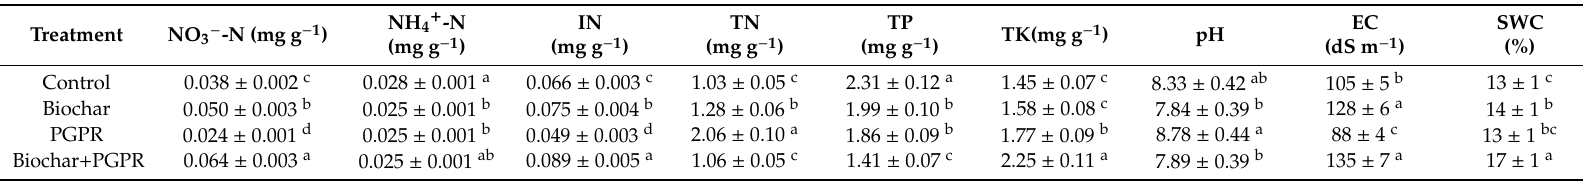
Table 4. Means and standard errors of soil nutrient contents amended with plant growth-promoting rhizobacteria (PGPR) and biochar. Di ff erent letters indicate significant di ff erences at p < 0.05 among treatments and the control. NO 3 − -N: nitrate nitrogen; NH 4 + -N: ammonium nitrogen; IN: inorganic nitrogen; TN: total nitrogen; TP: total phosphorus; TK: total potassium; EC: electrical conductivity; SWC: soil water content.